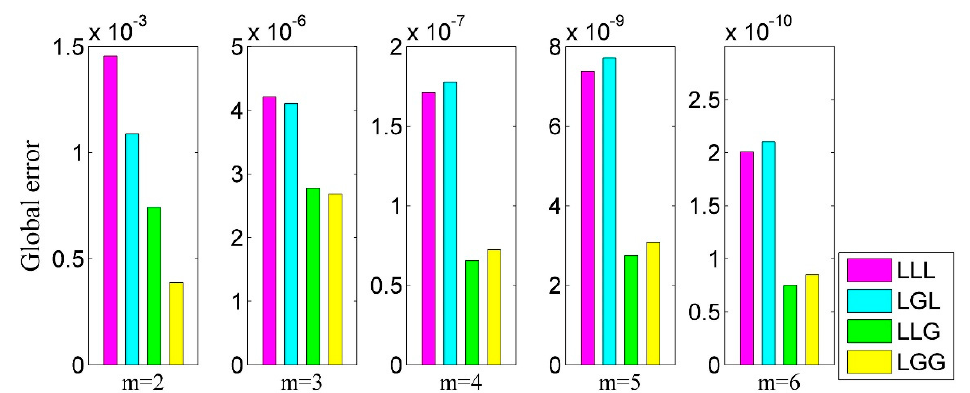
15 of 19 Figure 6. Triple pendulum: Global error of Hamiltonian of LLL, LGL, LLG and LGG with 2, 3, 0.1 η= . 4.4. Example 3: Six Balls In this section, we show the long-time energy behaviors, the conservation of angular momentum and the structure-preserving properties through a numerical example.